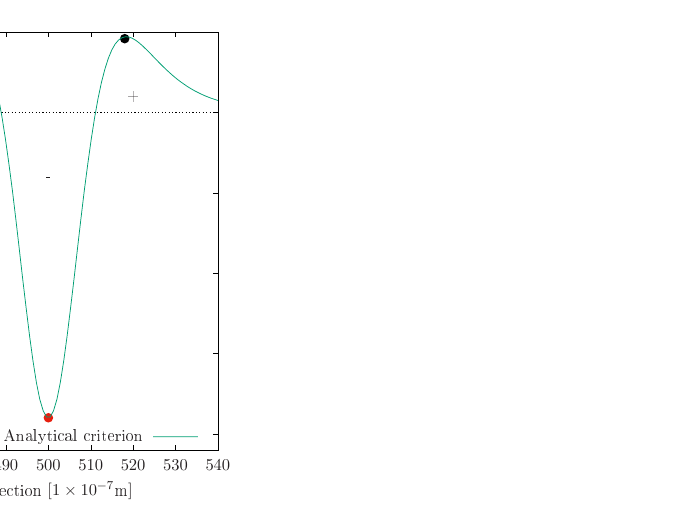
2 < 0 region, whereas the two tips start to evolve at the s κ ∇